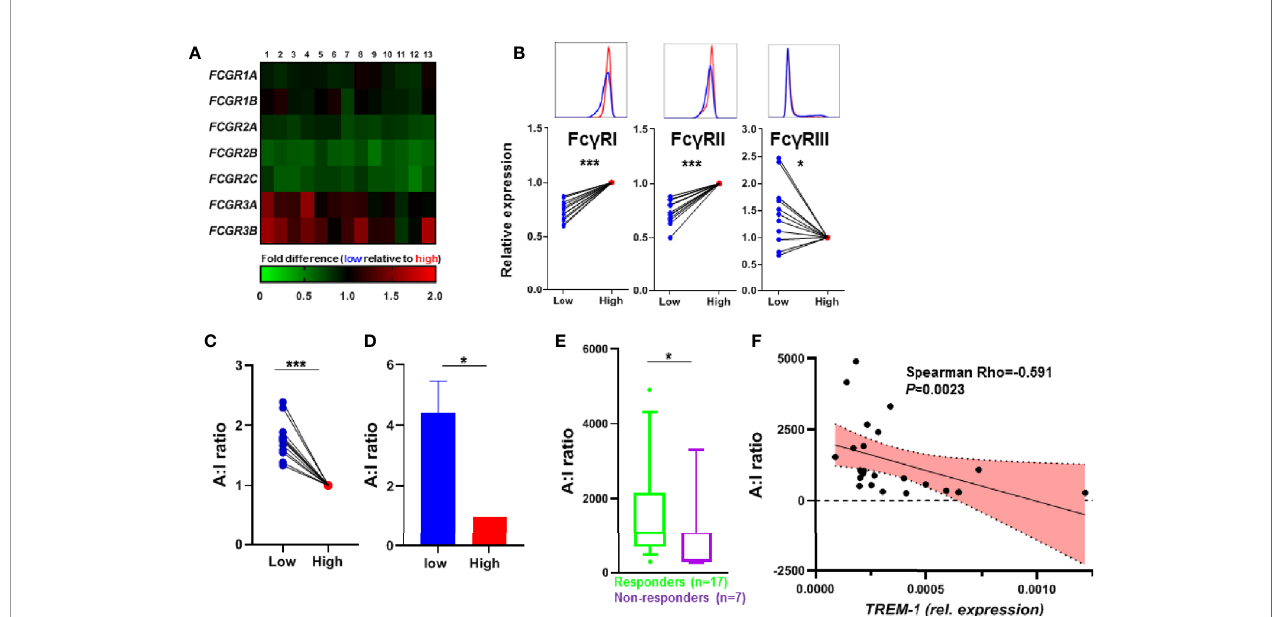
FIGURE 4 | TREM-1 expression and Fc g R signaling. (A) Heatmap of the expression of FCGR transcripts, paired expression of the TREM-1 low population relative to the TREM-1 high population of different donors (n=13). (B) The protein levels of Fc g RI, Fc g RII and Fc g RIII were determined by fl ow cytometry. The MFI was corrected for isotype control on TREM-1 low and high CD14+ gated monocytes and expressed as the TREM-1 low population relative to TREM-1 high for each donor (n=12). (C) The Fc g R A:I ratio determined by dividing the FCGR3A expression (activating) by the FCGR2B expression (inhibitory) of (B) , as suggested by Castro-Dopico et al . validated by the Fc g R A:I ratio determined by FCGR3A and FCGR2B qPCR on the sorted samples from Figure 1D in (D) (n=4). The Fc g R A:I ratio of the CD14+ monocytes from CD patients (n=24) before the start of anti-TNF therapy (E) and in correlation to the TREM-1 expression levels (G) . Mean + SEM is shown in (D) , whiskers indicate the 10-90 percentiles in (F) . Signi fi cance was determined by Wilcoxon signed rank tests (B, C) , a paired t-test (D) , and Mann Whitney (E) with *P < 0.05, ***P <